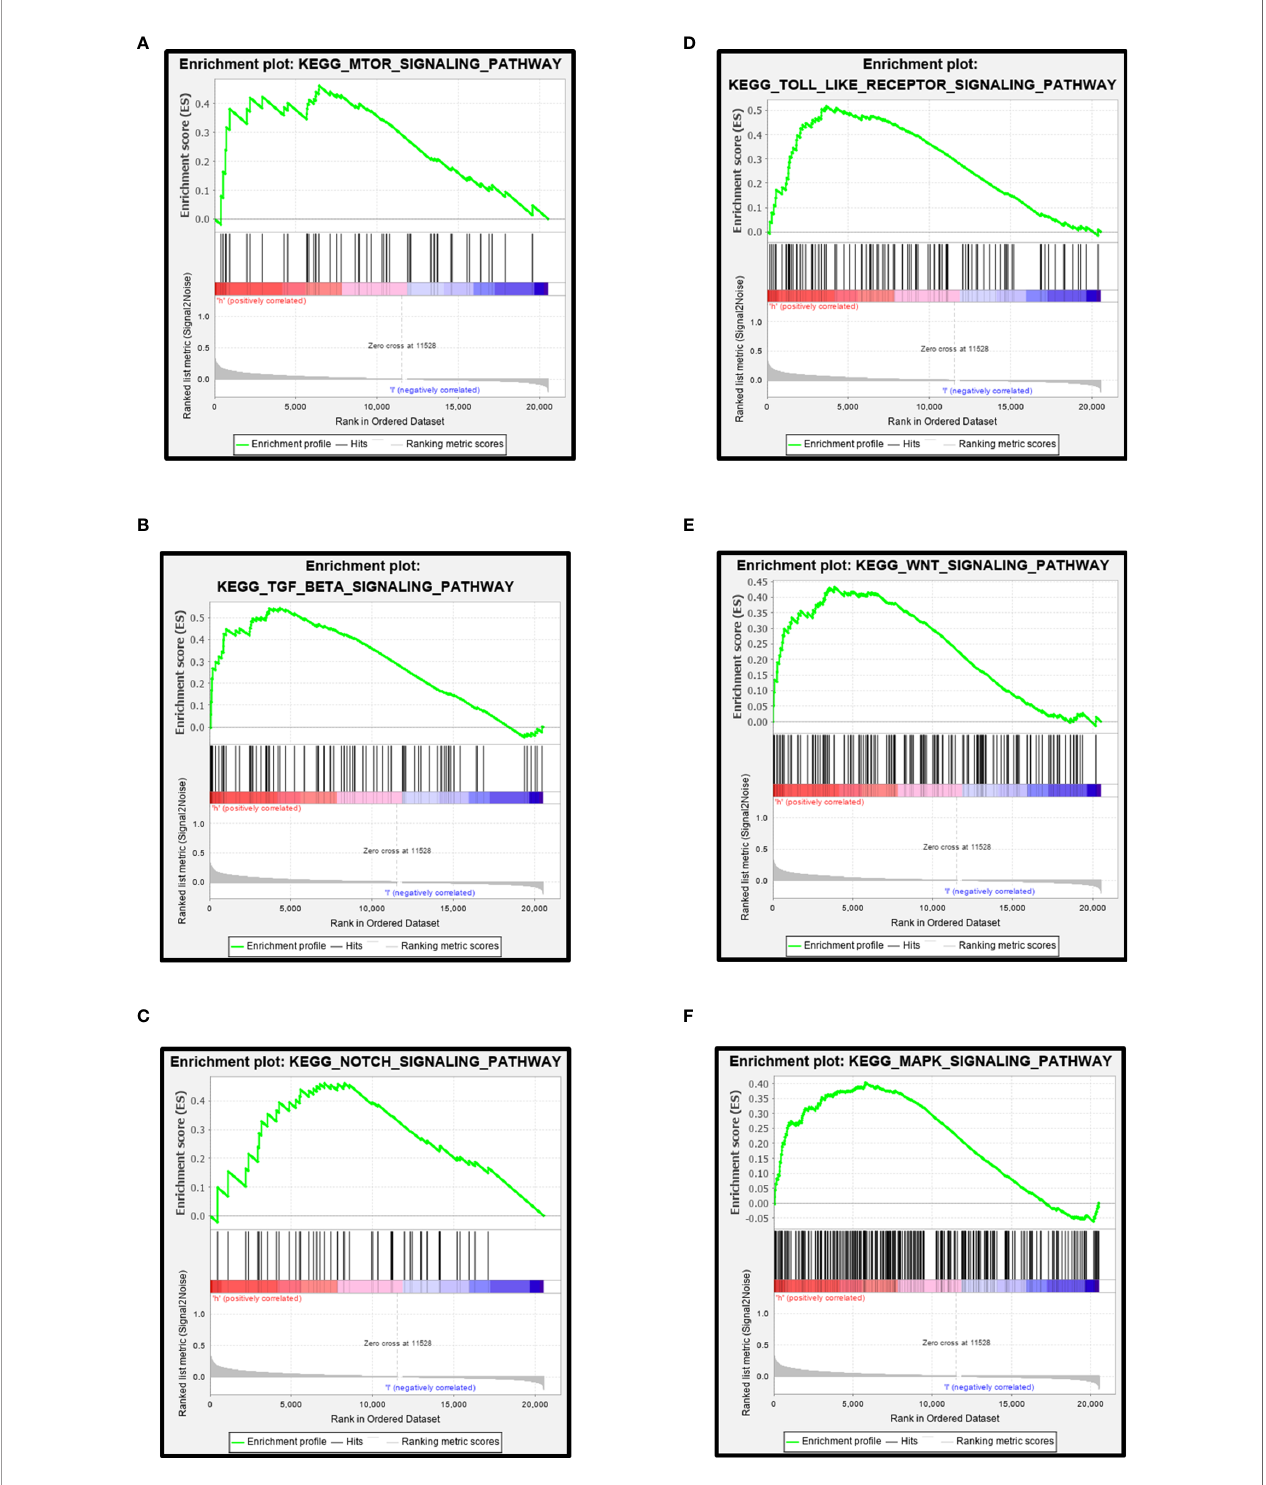
FIGURE 7 | Gene set enrichment analysis of CPN2 in lung adenocarcinoma. The high expression of CPN2 was signi fi cantly enriched in the mTOR signaling pathway (A) , TGF-BETA signaling pathway (B) , NOTCH signaling pathway (C) , TOLL-like-receptor signaling pathway (D) , WNT signaling pathway (E) , and MAPK signaling pathway (F) . False discovery rate <0.25 was considered statistically signi fi